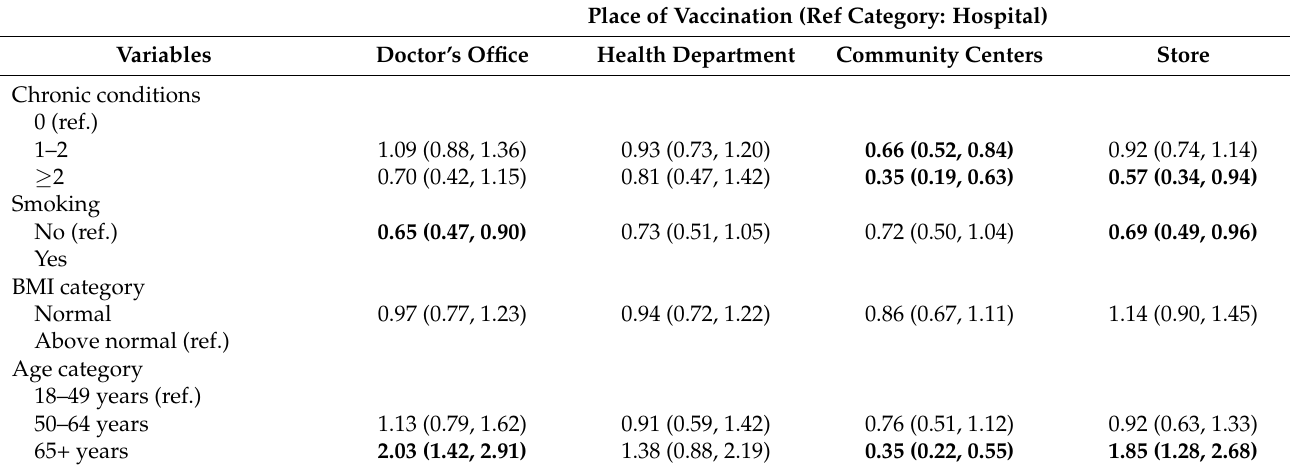
Table 2. Odds ratios and 95% CIs from multinomial logistic regression of place of vaccination on individual characteristics, BRFSS 2018. Place of Vaccination (Ref Category: Hospital)